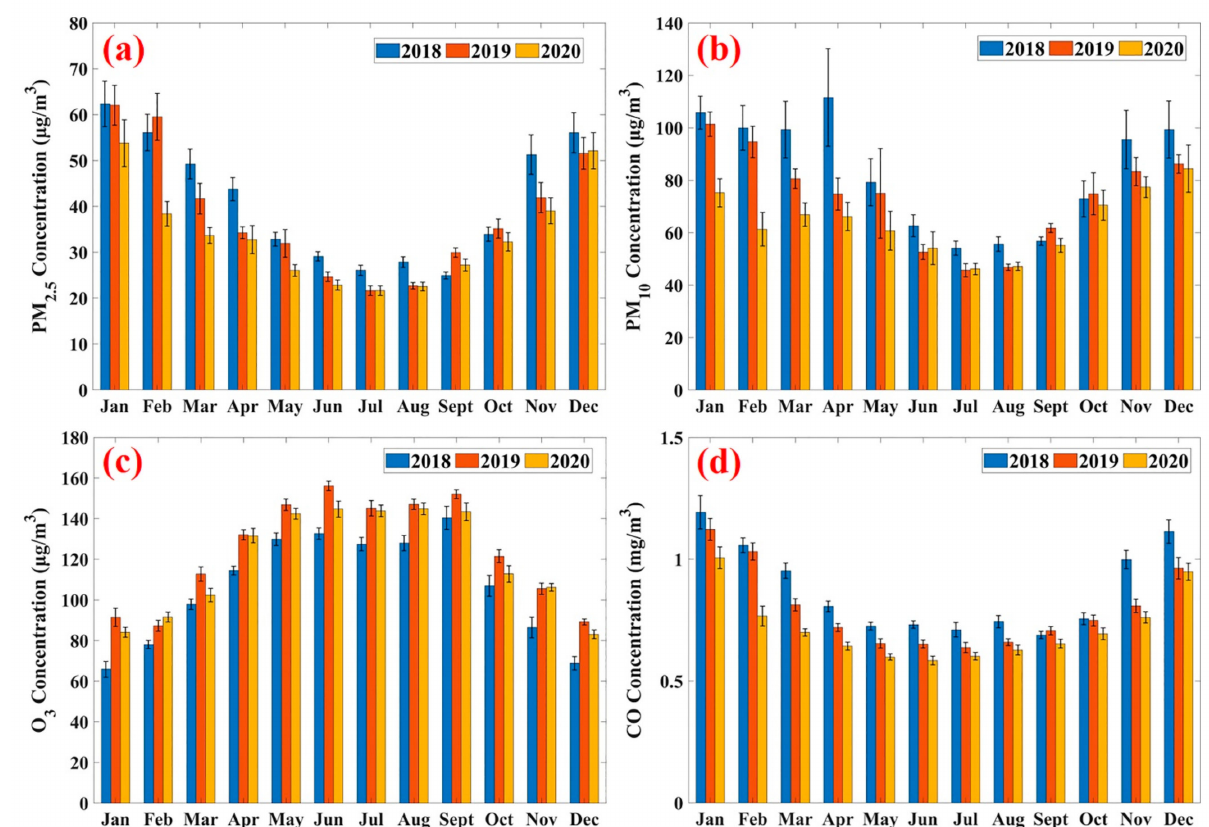
Figure 9. Mean concentrations changes of PM 2.5 , PM 10 , O 3 , and CO based on geographical RF model from 2018 to 2020. ( a ) PM 2.5 , ( b ) PM 10 , ( c ) O 3 , and ( d )